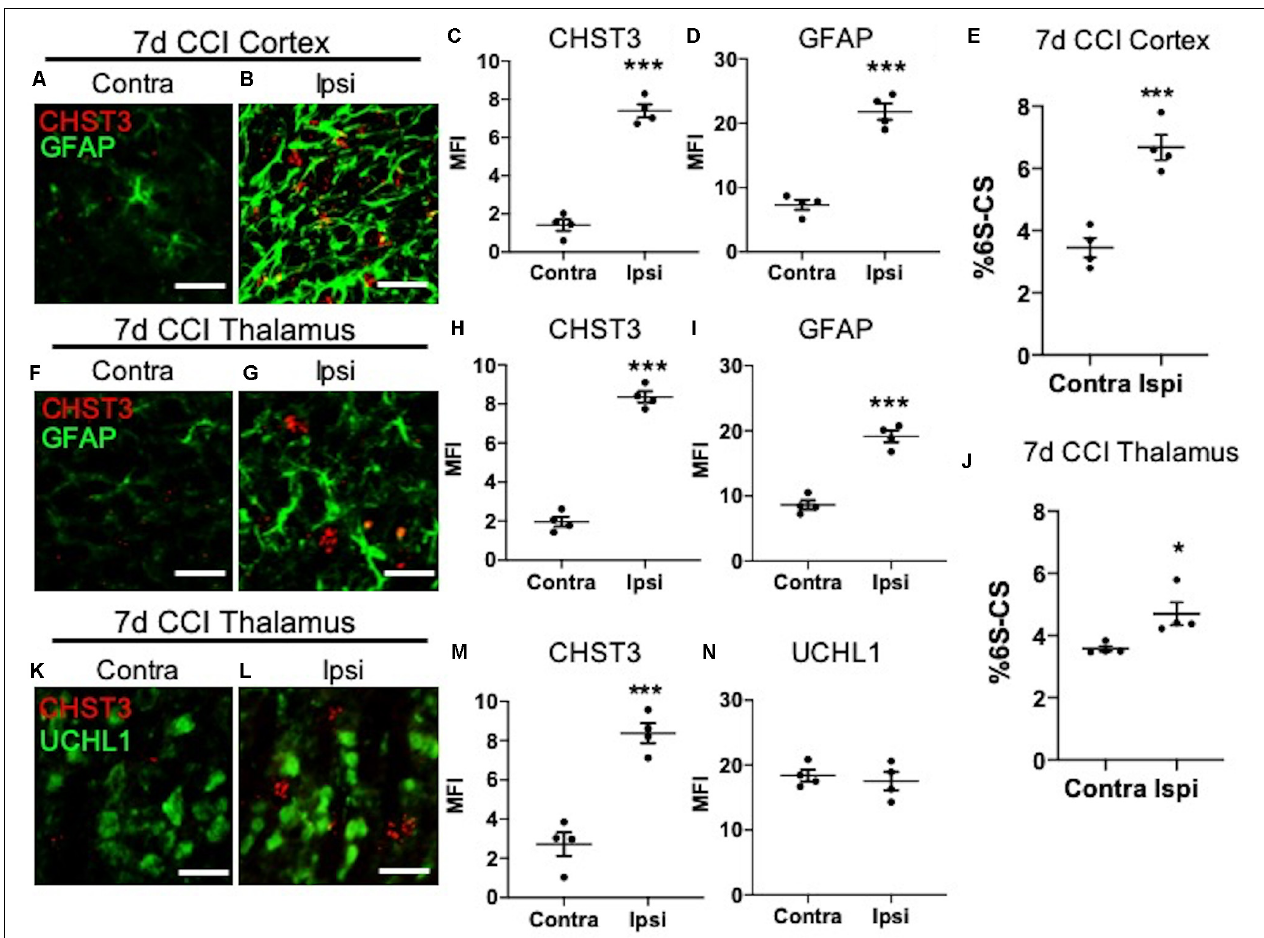
FIGURE 3 | Elevation of CHST3 expression and 6S-CS isomer abundance at the site of cortical injury and ipsilateral thalamus at 7 days post-CCI. Representative images of RNAscope analysis paired with immunofluorescent analysis showed low expression of the 6S-CS-specific sulfotransferase, CHST3, and GFAP in the contralateral cortex (A) relative to the ipsilateral cortex (B) at 7 days post-CCI, and quantified in (C) and (D) . LC-MS/MS analysis found an increase in the relative abundance of ipsilateral 6S-CS compared to the contralateral cortex (E) . Low expression of CHST3 and GFAP was observed in the contralateral thalamus (F) compared to the ipsilateral thalamus (G) 7 days post-CCI, and quantified in (H) and (I) . A significant increase in the relative abundance of 6S-CS was measured in the ipsilateral thalamus (J) , compared to the contralateral thalamus 7 days post-CCI. Low expression of CHST3, yet normal expression of UCHL1, was observed in the contralateral thalamus (K) compared to the ipsilateral thalamus (L) 7 days post-CCI, and quantified in (M) and (N) . (C–E,H–J,M,N) Student’s t -test. Values represent means ± SD ( N = 4, * P < 0.05 ; *** P < 0.001 ). Scale bars = 20 µ m. CHST3, carbohydrate sulfotransferase 3; CCI, controlled cortical impact; UCHL1, ubiquitin C-terminal hydrolase L1; GFAP, Glial fibrillary acidic